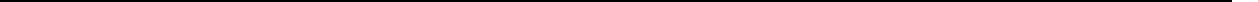
Fig. 3 Interaction of CXCR3 with LRP1. a Super resolution microscopy (STED) for U87-CXCR3-A cells (CXCR3 λ = 594 nm, LRP1 λ = 647 nm). Zoom 1 represents the perinuclear area in the cell and zoom 2 the membrane area of the cell. Scale: 5 and 1 µ m (zoom). ×1000 magni fi cation under a Leica SP8-STED microscope. The graph depicts the percentage of colocalization of each fl uorophore with CXCR3 or LRP1 ( n = 30). *** P < 0.001. Statistical comparison between two groups was performed using the Mann – Whitney U -test. b Immunoprecipitation against LRP1 (IP LRP1 α , antibody LRP1 8G1 for glioma cells, and antibody LRP1 D2642 for CaSMC) and western blot of the CXCR3:LRP1 complex (antibody 8G1 for LRP1 α and 5A6 and 2703-1 for LRP1 β ) in glioma cells and coronary artery smooth muscle cells (CaSMC). CTRL IgG negative control of beads with IgG. c , d Immunoprecipitation against LRP1 (IP LRP1 α , antibody LRP1 8G1) and western blot of the CXCR3:LRP1 complex (antibody 8G1 for LRP1 α ) in U87-CTRL and U87-CXCR3-A tumors implanted in the CAM ( c ) and in several GBM cell lines derived from patients ( d ). e Western blot probed with anti-CXCR7 and anti-CXCR3 antibodies in U87-CXCR3-A and immunoprecipitation against LRP1 (IP LRP1 α , antibody LRP1 8G1). The experiments have been repeated three times with identical results. f Proximity ligation assay (PLA) in U87-CXCR3-A cells between CXCR3 and LRP1 using anti-CXCR3 (mouse 2 ar1) and anti-LRP1 antibodies (2703-1, rabbit monoclonal antibody for LRP1 β